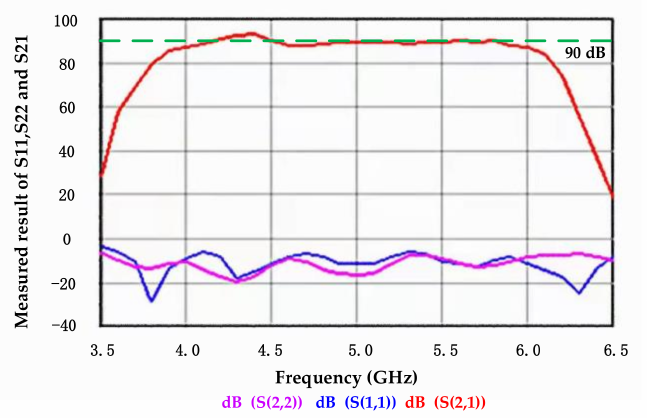
Figure 10. Measured result of S11, S22, and S21 of RF front end